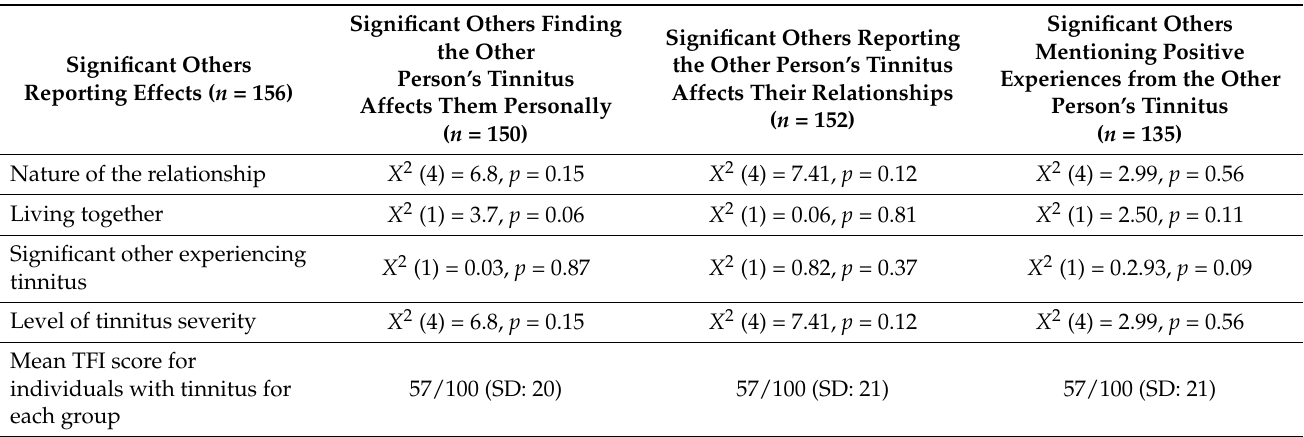
Table 2. The association between significant others’ characteristics and those reporting that tinnitus affected